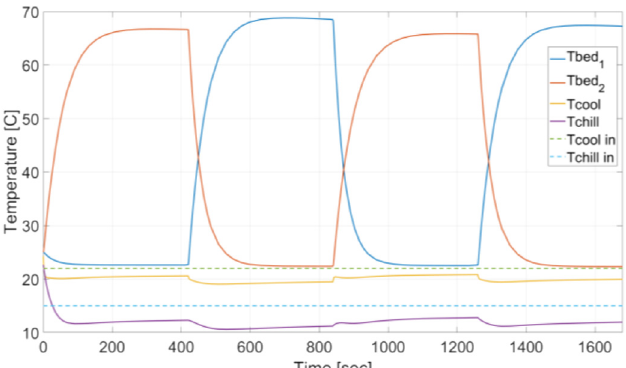
Fig. 4. Overall outlet temperature pro fi le of heat transfer fl uid for two beds adsorption